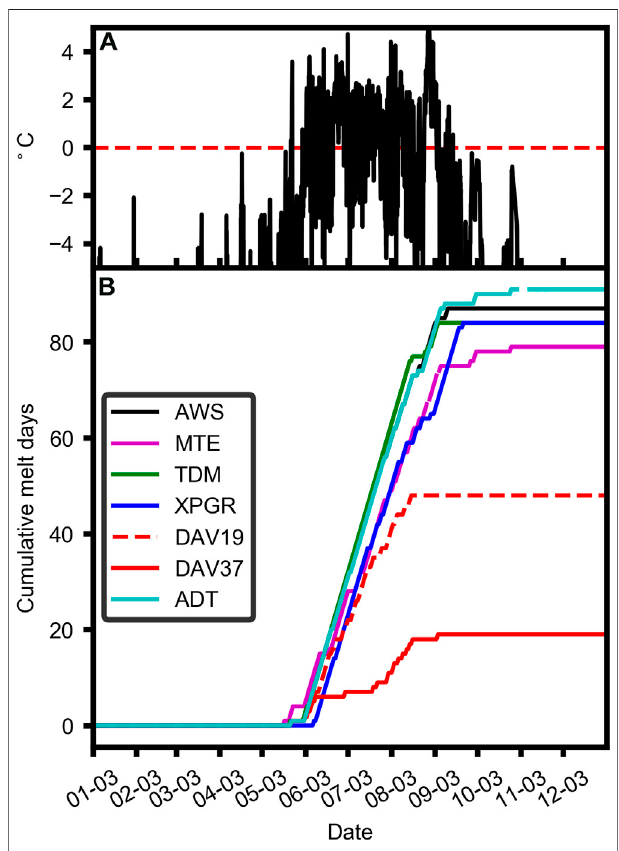
FIGURE 3 | Hourly average near surface air temperature (A) , and cumulative melt days from measurement and microwave products (B) at the SwissCampAWSin2003.Reddashedlinein (A) references0 ° Ctemperature threshold.